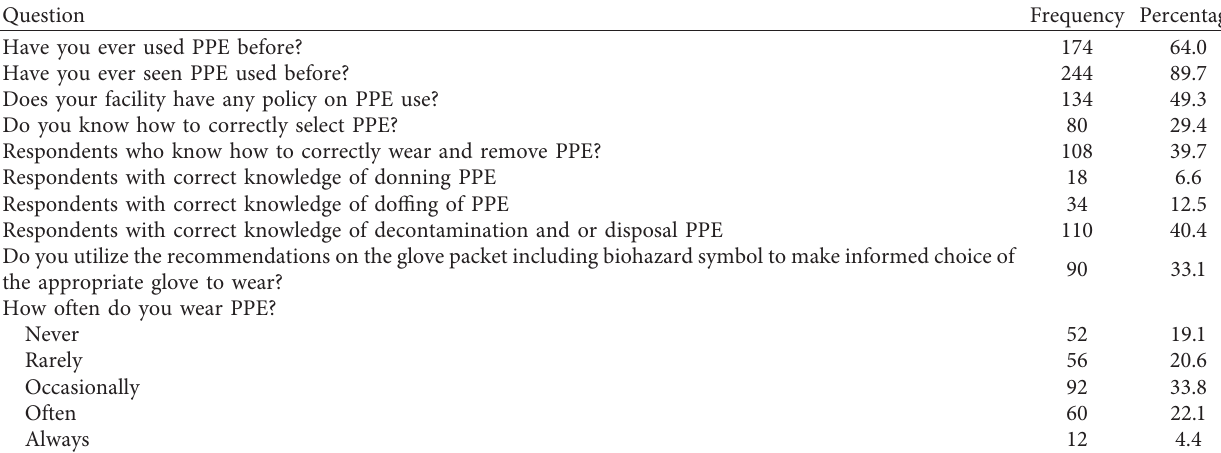
Table 6: Healthcare workers’ PPE skill in practice ( N �